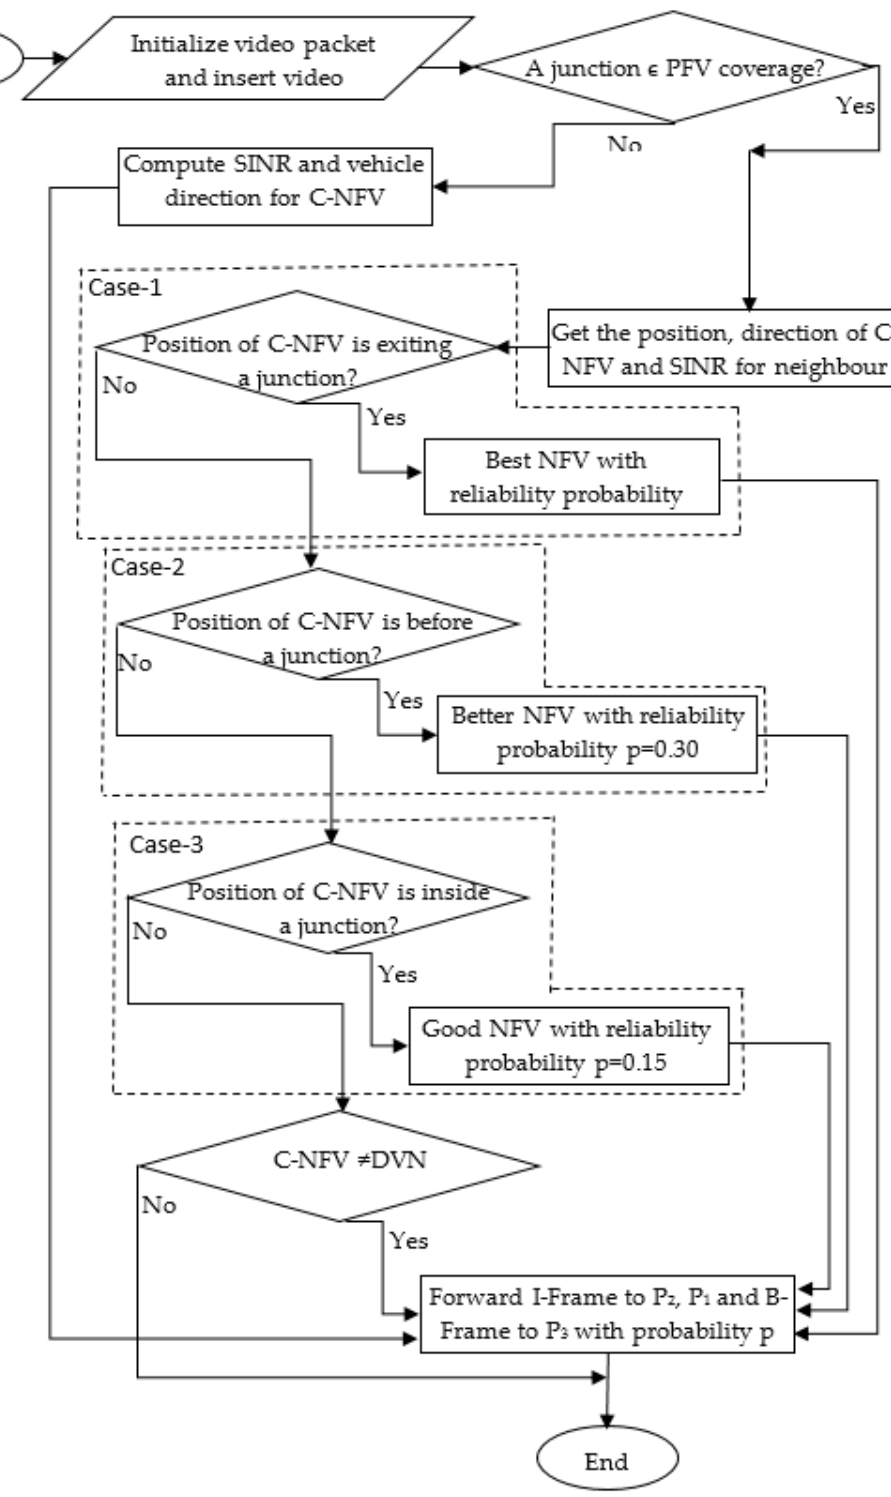
Figure 3. Flowchart for vehicle selection considering the junction area. C-NFV: Candidate Next Forwarding Vehicle; SINR: signal to interference plus noise ratio; DVN: Destination Vehicle Node.